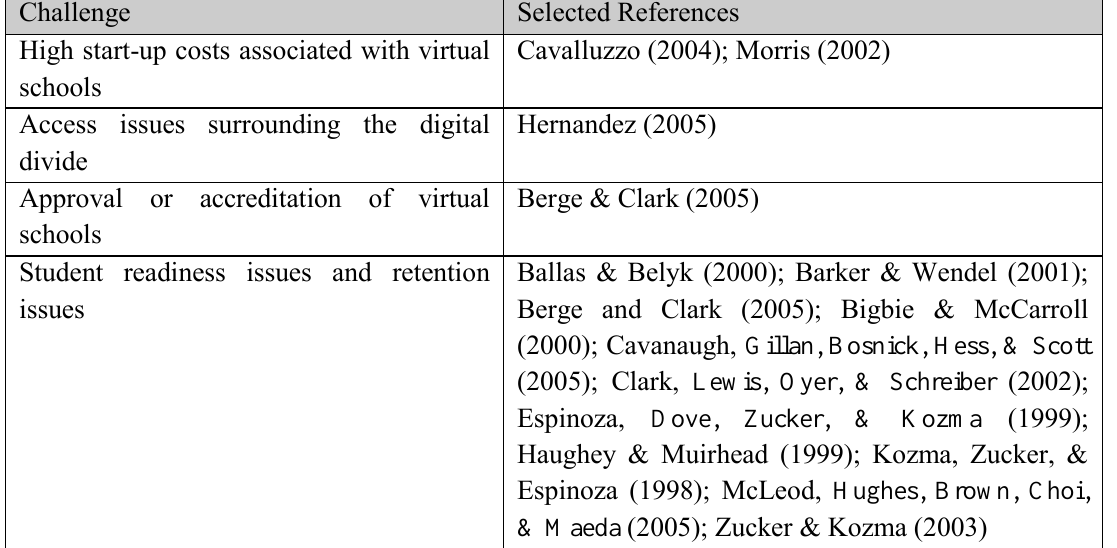
Challenges of Virtual Schooling (Barbour and Reeves, 2009, p.